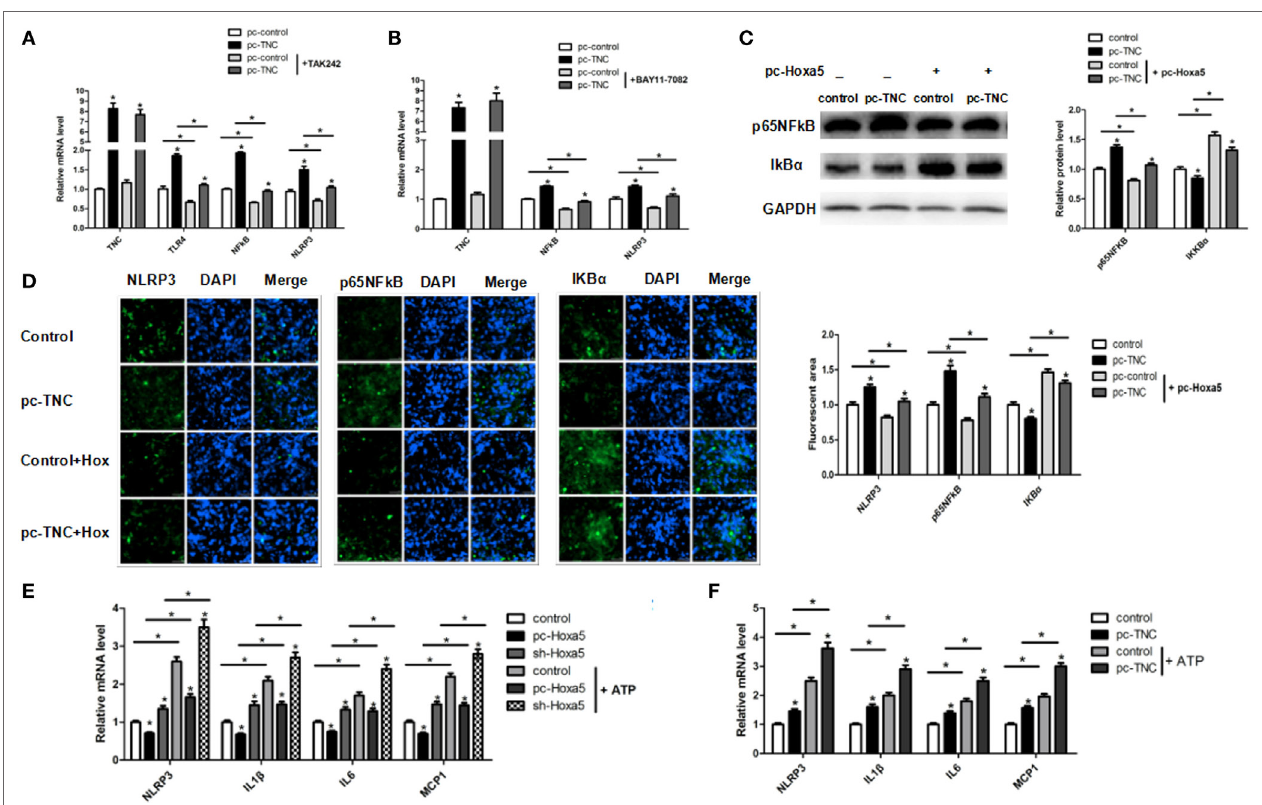
FigUre 7 | Tenascin C (TNC) facilitates adipocytes inflammation via activating the Toll-like receptor (TLR) 4/nuclear factor kappa B (NF- κ B)/NLRP3 pathway. (a) Relative mRNA expression level of TNC, TLR4, and NF- κ B in mice adipocytes in control group, a pc-TNC group with or without treatment of TLR4 inhibitor TAK242 ( n = 4). (B) Relative mRNA expression level of TNC, NF- κ B, and NLRP3 in mice adipocytes in control group, a pc-TNC group with or without treatment of NF- κ B inhibitor BAY11-7082 ( n = 4). (c) Representative immunoblots and densitometric quantification for IL1 β , IL6, TNF α , and NLRP3 in mice adipocytes co-treatment with pc-TNC and pc-Hoxa5 under lipopolysaccharide (LPS) treatment ( n = 4). (D) Images of adipocytes stained by immunofluorescent staining in mice adipocytes co-treatment with pc-TNC and pc-Hoxa5 under LPS treatment ( n = 4). (e,F) Relative mRNA level of NLRP3, IL1 β , IL6, MCP1 in mice adipocytes in different groups with or without ATP treatment under LPS stimulation ( n = 4). Values are represented as means ± SD vs. control group, * p <